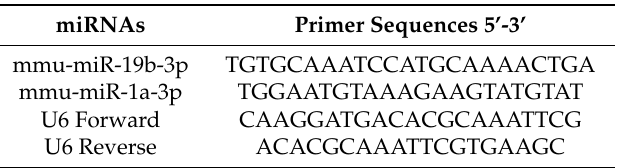
Table 2. Specific primers for real-time PCR analysis of miRNA.